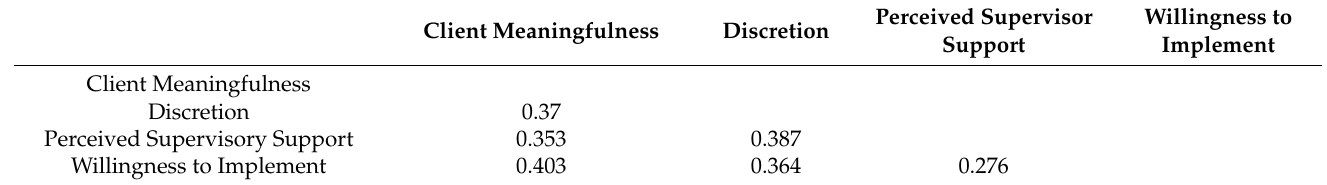
Table 2. Discriminant validity (HTMT